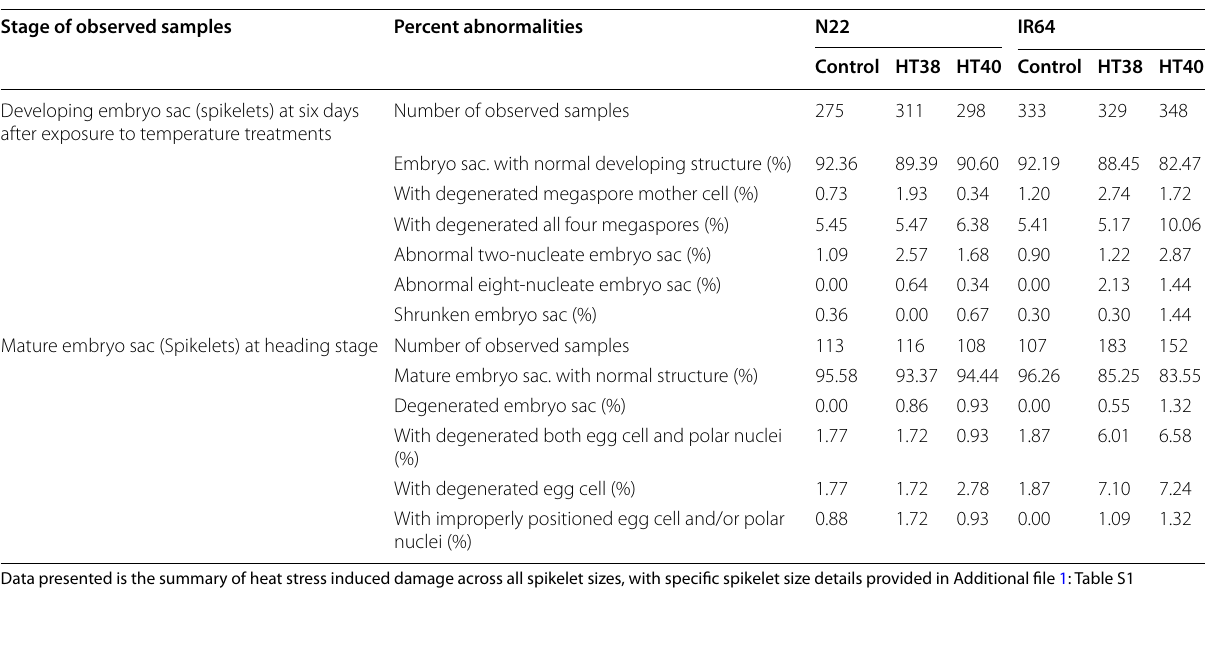
Table 1 Percentage abnormalities in the embryo sac samples of N22 and IR64 at six days after exposure to control (30 °C) and heat